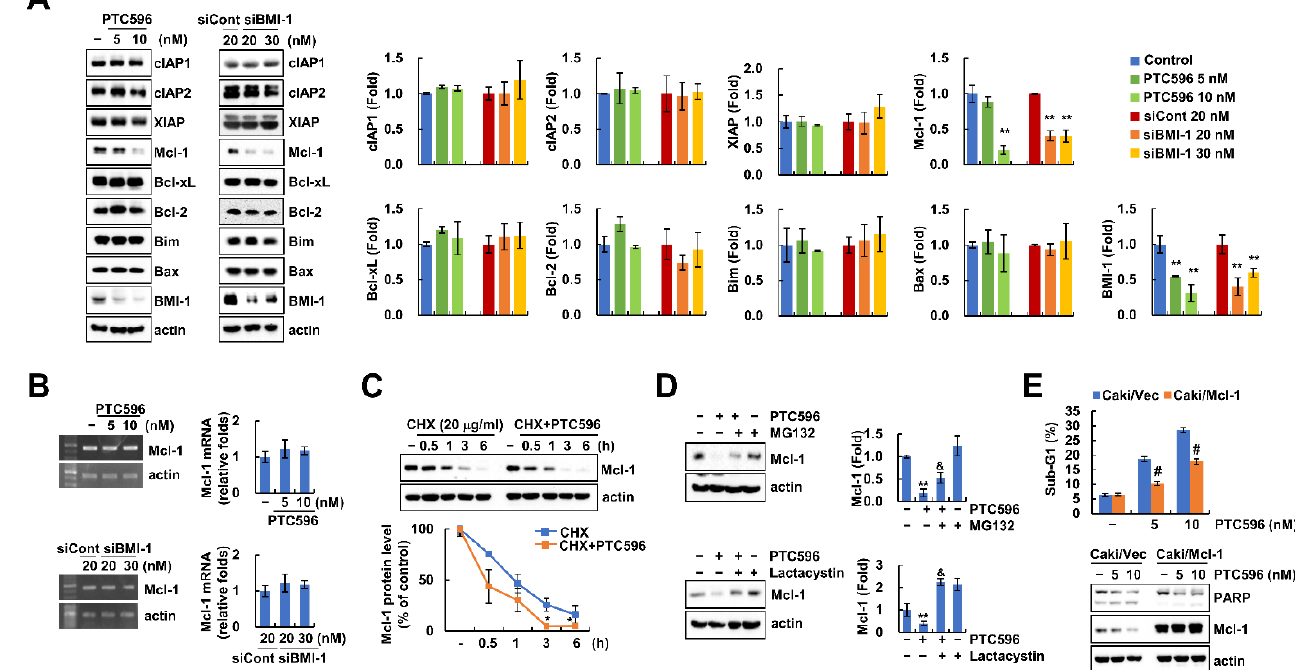
Figure 3. Downregulation of Mcl-1 is involved in PTC596-induced apoptosis. ( A , B ) Caki cells were treated with PTC596 (5, 10 nM) for 24 h or transfected with Cont and BMI-1 siRNA for 24 h; ( C ) Caki cells were treated with or without PTC596 (10 nM) in the presence of cycloheximide (20 μg/mL) for the indicated time periods; ( D ) Caki cells were pre-treated with MG132 (1 µ M) and lactacystin (2.5 µ M) for 30 min, then treated with PTC596 (10 nM) for 24 h; ( E ) Vector cells (Caki/Vec) and Mcl-1 overexpressed cells (Caki/Mcl-1) were treated with PTC596 (5, 10 nM) for 24 h. The sub-G1 population and protein expression were measured by flow cytometry and Western blotting ( A , C – E ). The mRNA levels of Mcl-1 and actin were quantified by RT-PCR ( B, upper panel) and real-time PCR ( B , lower panel). The band intensity was examined using Image J ( A , C , D ). The values in graphs ( A – E ) represent the mean ± SD of three independent samples. ** p < 0.01 compared to control. * p < 0.01 compared to CHX alone. & p < 0.05 compared to PTC596. # p < 0.05 compared to the PTC596 in Caki/Vec cells.